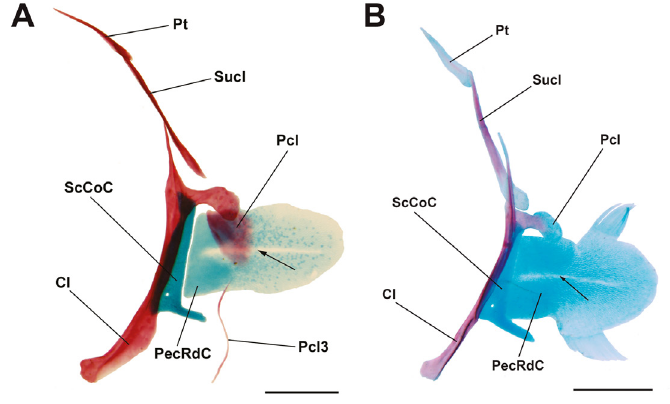
FIGURE 4 | Shoulder girdle in lateral view of A. Priocharax britzi , paratype, MZUSP 125823, 12.9 mm SL, c&s. Image flipped. B. Priocharax cf. ariel , UFRO 15521, 11.8 mm SL, c&s. Cl = cleithrum; PecRdC = pectoral-fin radial cartilage; Pcl = unidentified postcleithrum; Pcl3 = postcleithrum 3; Pt = posttemporal; ScCoC = scapulocoracoid cartilage; Sucl = supracleithrum. Arrows point to middle fissure on pectoral-fin radial cartilage. Pcl3 slightly displaced ventrally from original position in A. Scale bars = 0.5 mm.